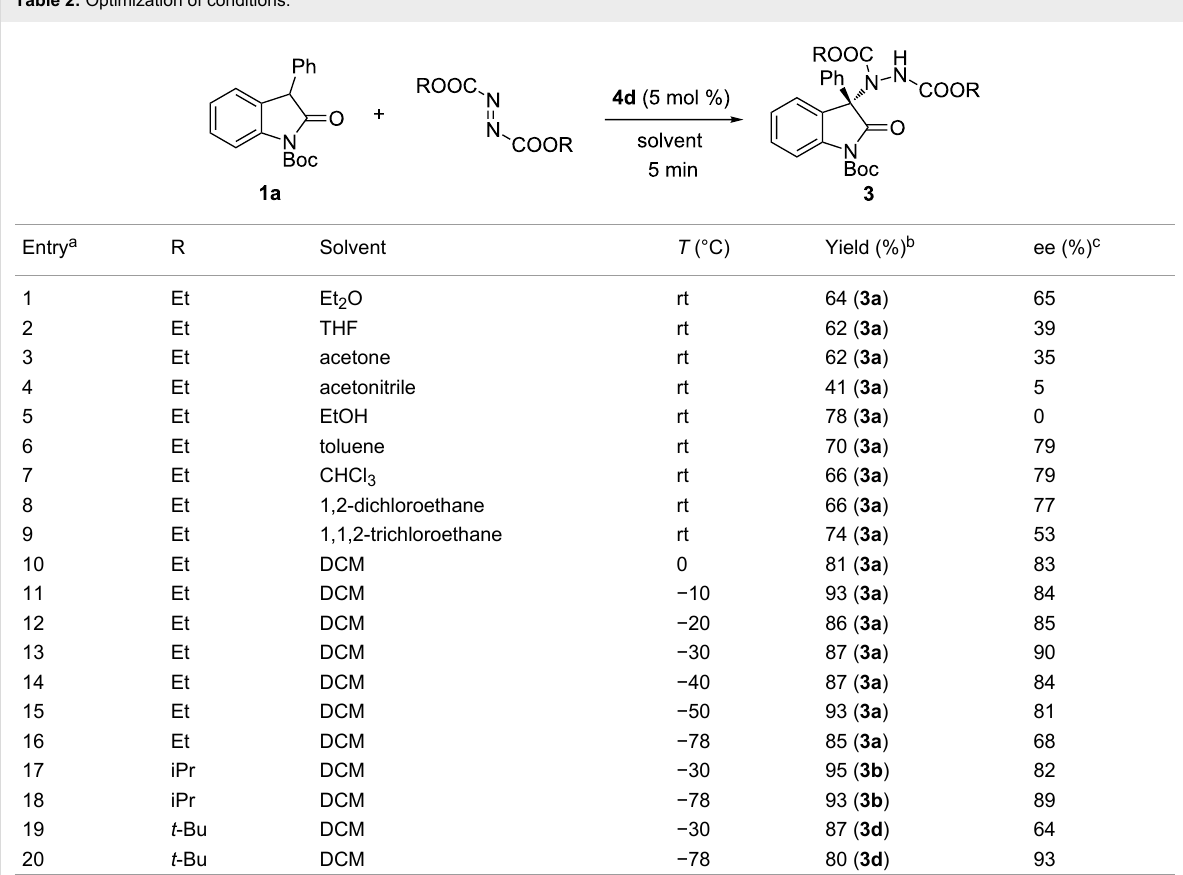
Table 2: Optimization of conditions.